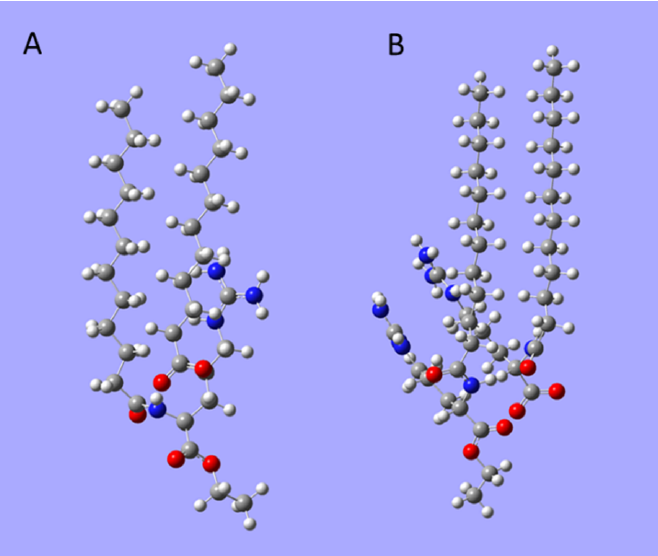
Figure 3. The optimised structures of ( A ) LAE-dodecanoate, ( B ) LAE-LAS heterodimers. Grey, carbon; white, hydrogen; red, oxygen; blue, nitrogen.